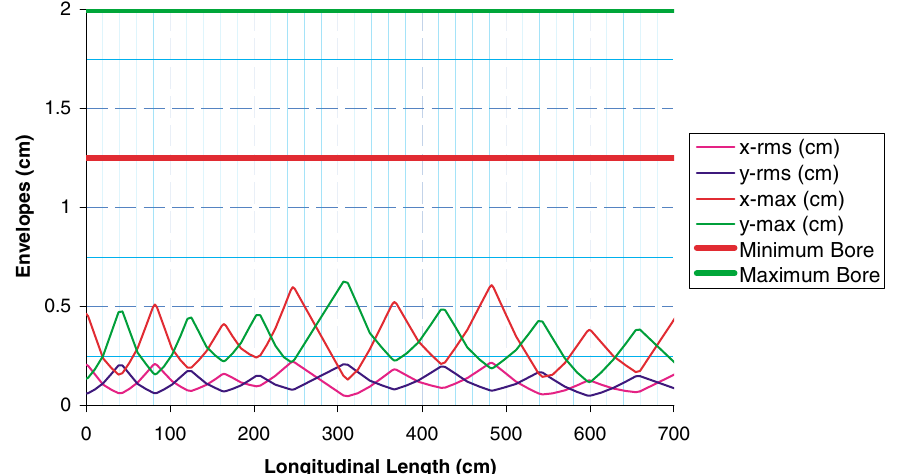
FIG. 3. (Color) Transverse beam envelopes (rms and maximum values) for 5 mA compared with maximum and minimum bore